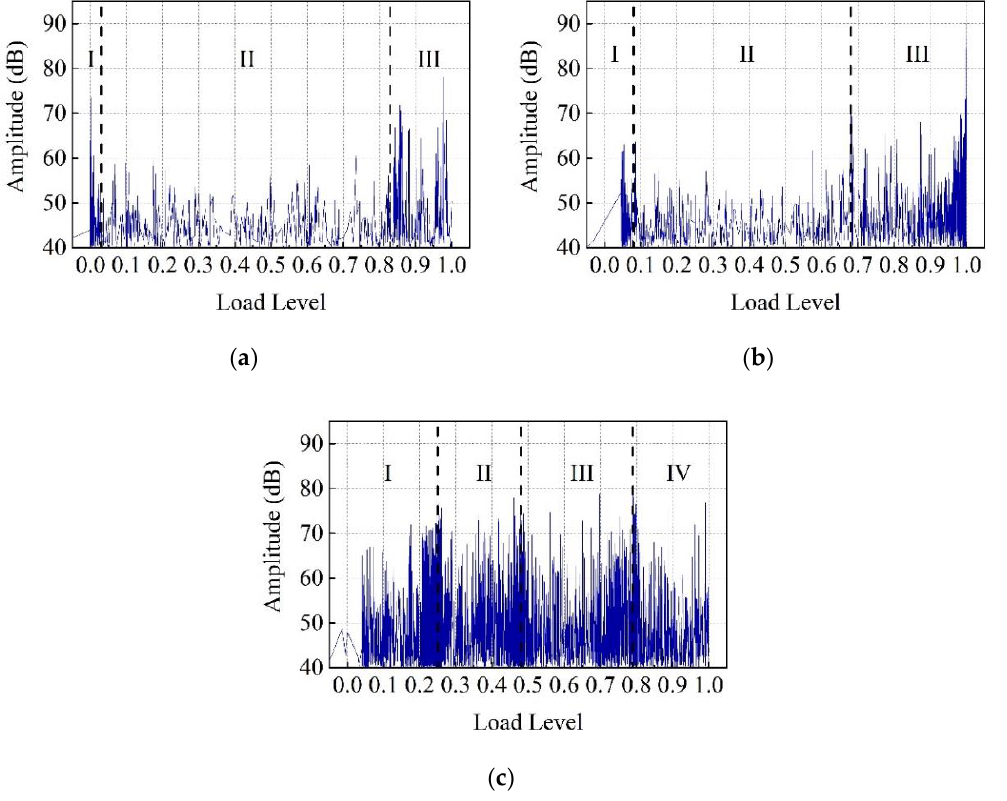
Figure 9. Distribution of amplitude: ( a ) basalt fiber content of 6 kg/m³; ( b ) basalt fiber content of 10 kg/m³; and ( c ) basalt fiber content of 14 kg/m³.